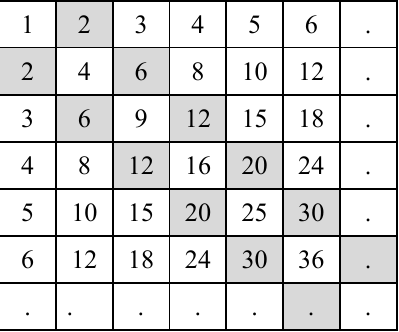
Figure 9 : The sequence of numbers below and above the square numbers